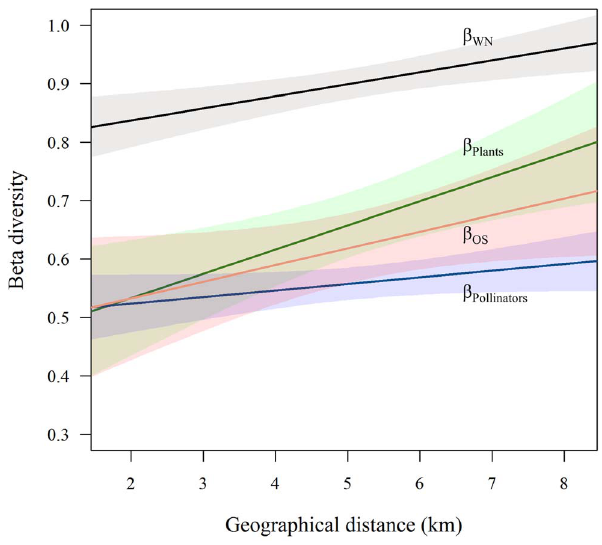
Figure 2. Beta diversity of species and interactions and geographical distance. Total interaction beta diversity b WN (black), plant beta diversity b Plants (green), beta diversity of interactions between shared species b OS (red), and pollinator beta diversity b Pollinators (blue) as a function of geographical distance between sites. All measures relate positively to geographical distance. Only for b Pollinators the correlation was non-significant ( b WN : P=0.002, R 2 =0.40, a =0.02; b OS : P=0.047, R 2 =0.19, a =0.03; b Plants : P=0.004, R 2 =0.37, a =0.04; b Pollinators : P=0.086, R 2 =0.15, a =0.01). Shaded areas delimit corresponding 95% confidence